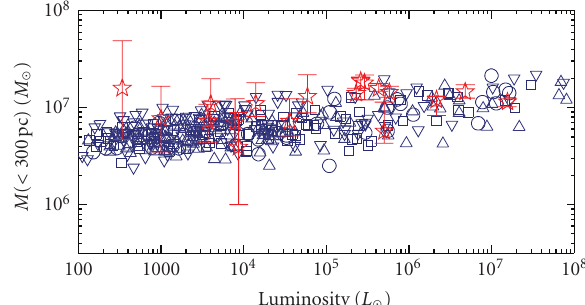
Figure 10: The mass within the central 300pc versus luminosity for the dwarf satellites of the Milky Way (stars with error bars, see [88]). The open symbols of di ff erent types show the expected relation for subhalos in three di ff erent Milky Way-sized halos formed in the simulations of the concordance Λ CDM cosmology if the luminosity of the subhalos is related to their virial mass at accretion epoch as L = 5 × 10 3 L (cid:4) ( M vir,acc / 10 9 M (cid:4) ) 2 . 5 (see text for